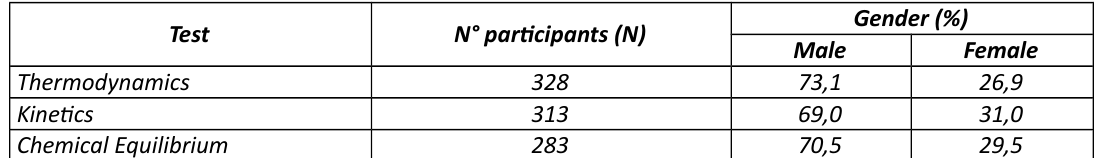
Table 1. Informaton about partcipants in the pilot implementaton of each test